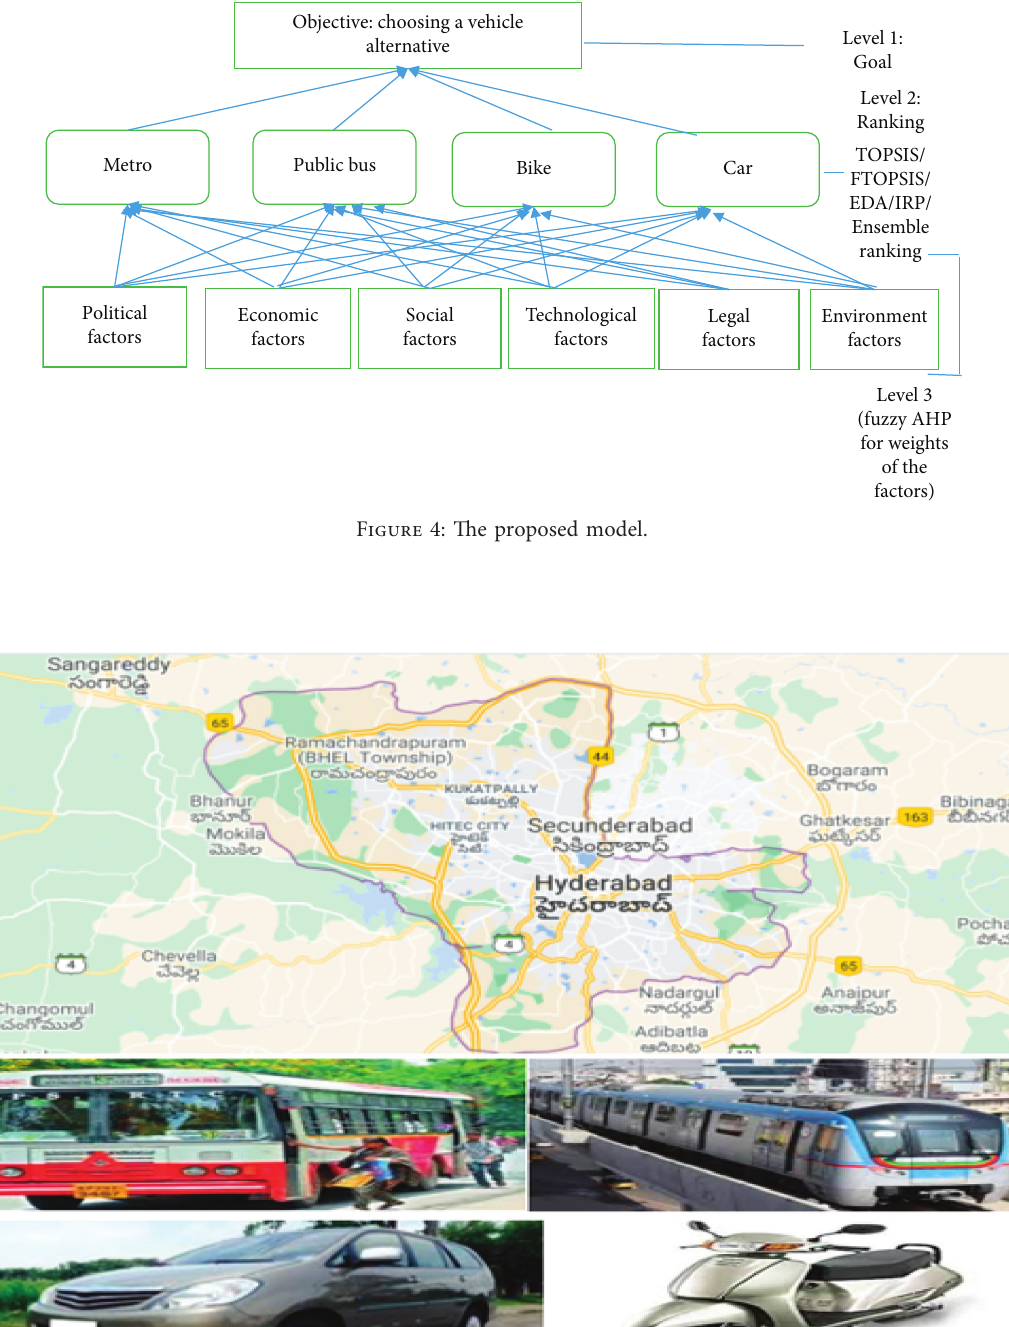
Figure 5: The modes of transport, their routes, and the study area (in clockwise order, public bus, metro train, bike, and